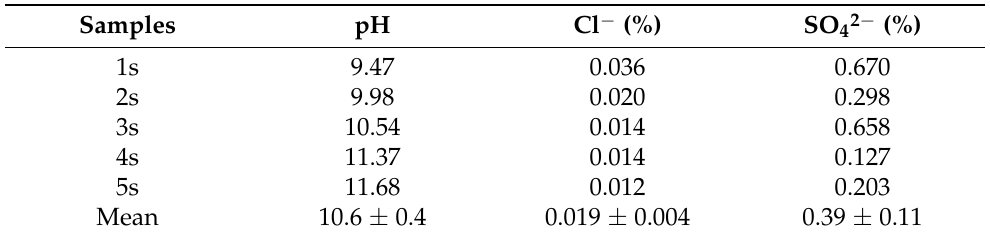
Table 5. pH values of concrete specimens and content of chloride ions and sulfate ions in concrete as a percentage of dry weight for the cover layer.